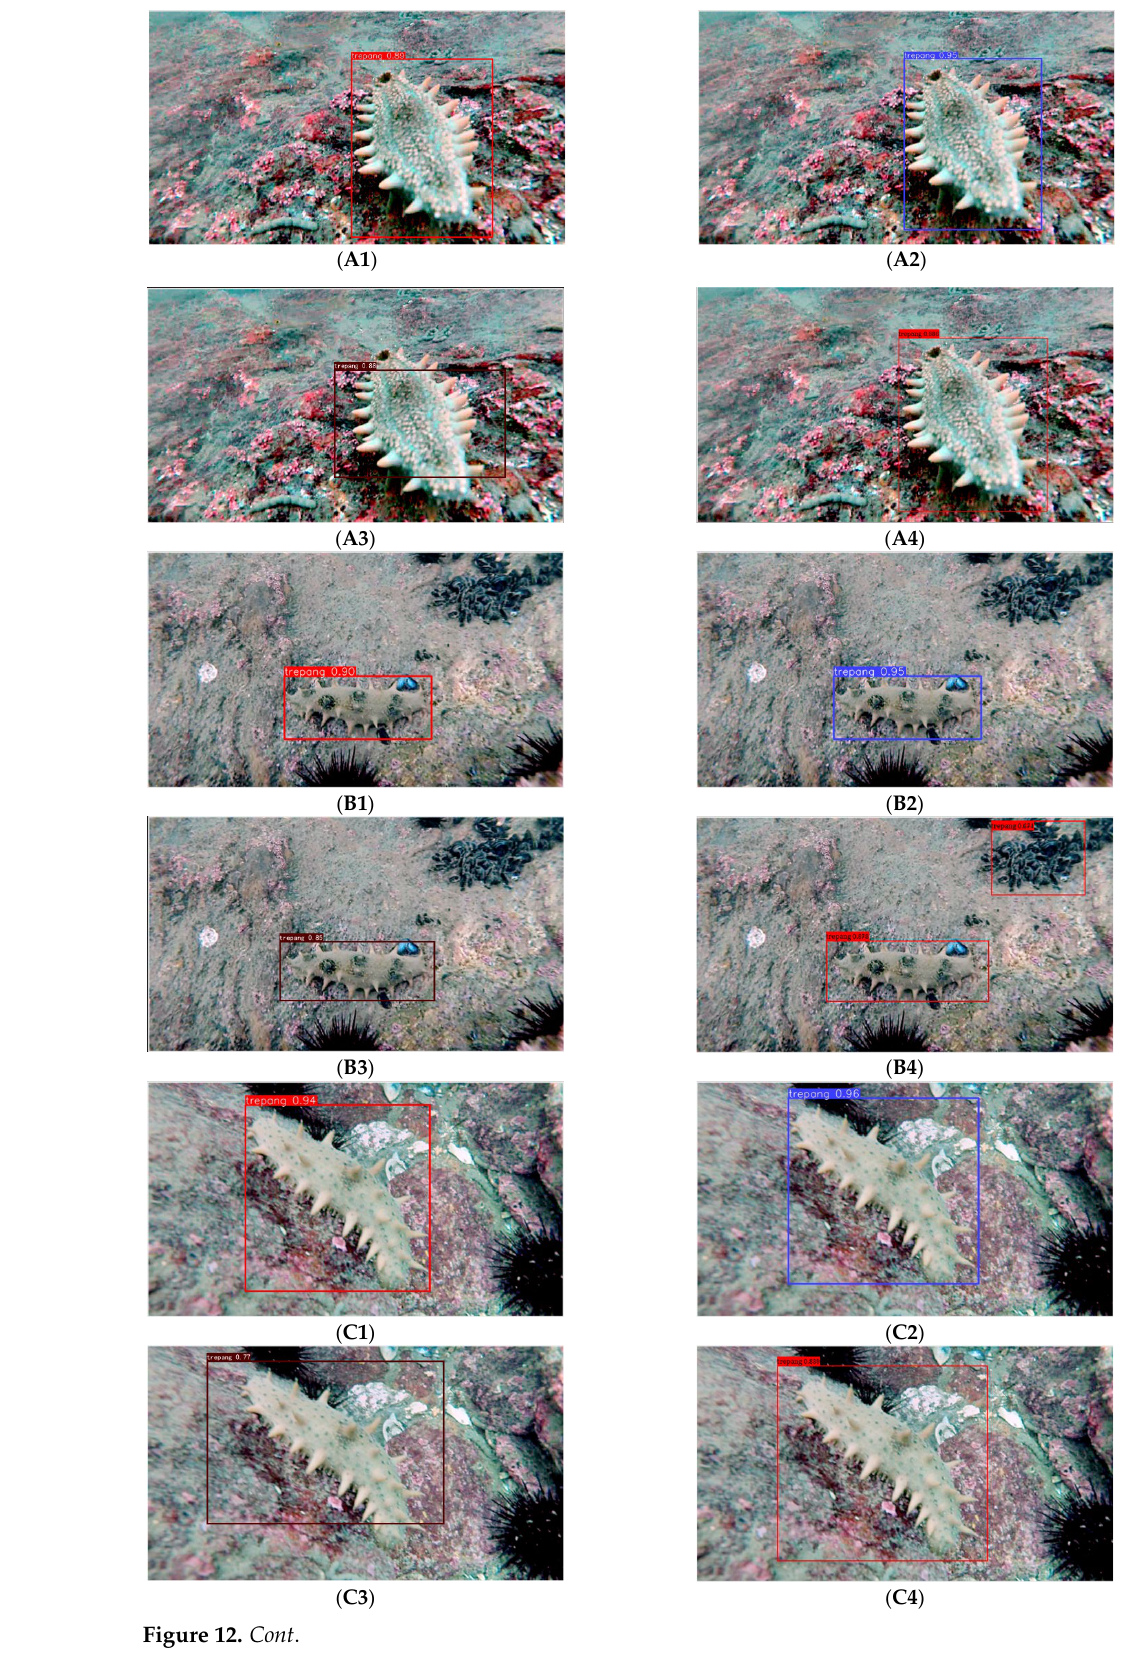
( f ) Figure 11. Test the Image After Improvements: image ( a – c ) is the results of the YOLOv5s; image ( b – d ) is the results of the improved YOLOv5s; image ( e ) is the result of YOLOv4; and image ( f ) is the result of Faster-RCNN. 5.2. Sea Cucumber Identification for Mixed Image Gallery Take images of sea cucumbers from different angles and different forms from multi- ple videos and mix the images to obtain a mixed image library. There are 4172 images in total, with training sets, validation sets, and test sets distributed according to 8:1:1. Images of sea cucumbers were identified using YOLOv5s, improved YOLOv5s, YOLOv4, and Faster-RCNN, and the experimental results are shown in Figure 12. A1, B1, C1, D1, and E1 of Figure 12 are the YOLOv5s identification results; A2, B2, C2, D2, and E2 of Figure 12 are the improved YOLOv5s identification results; A3, B3, C3, D3, and E3 of Figure 12 are the YOLOv4 recognition results, and A4, B4, C4, D4, and E4 of Figure 12 are the Faster- RCNN identification results.